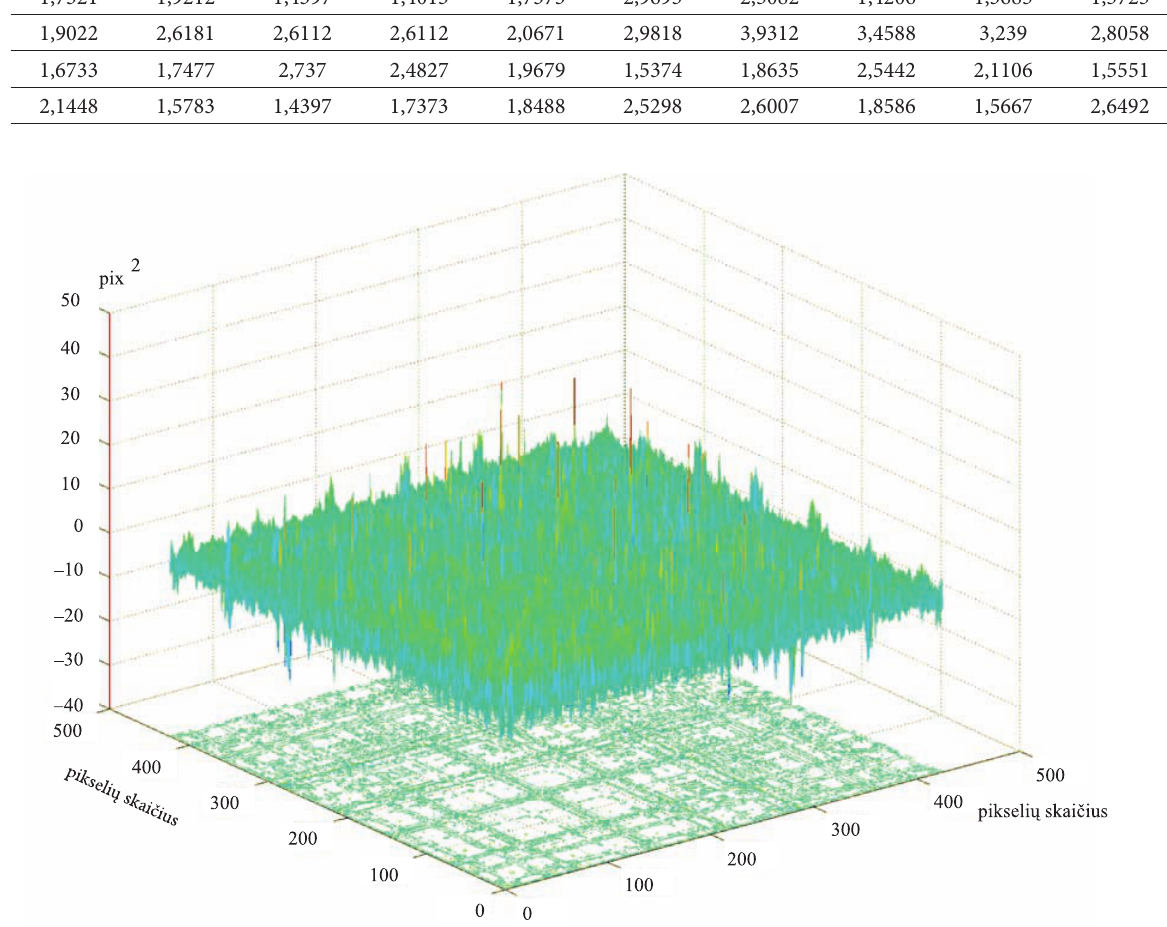
Fig. 2. The view of the two scales intercorrelation in the three colors